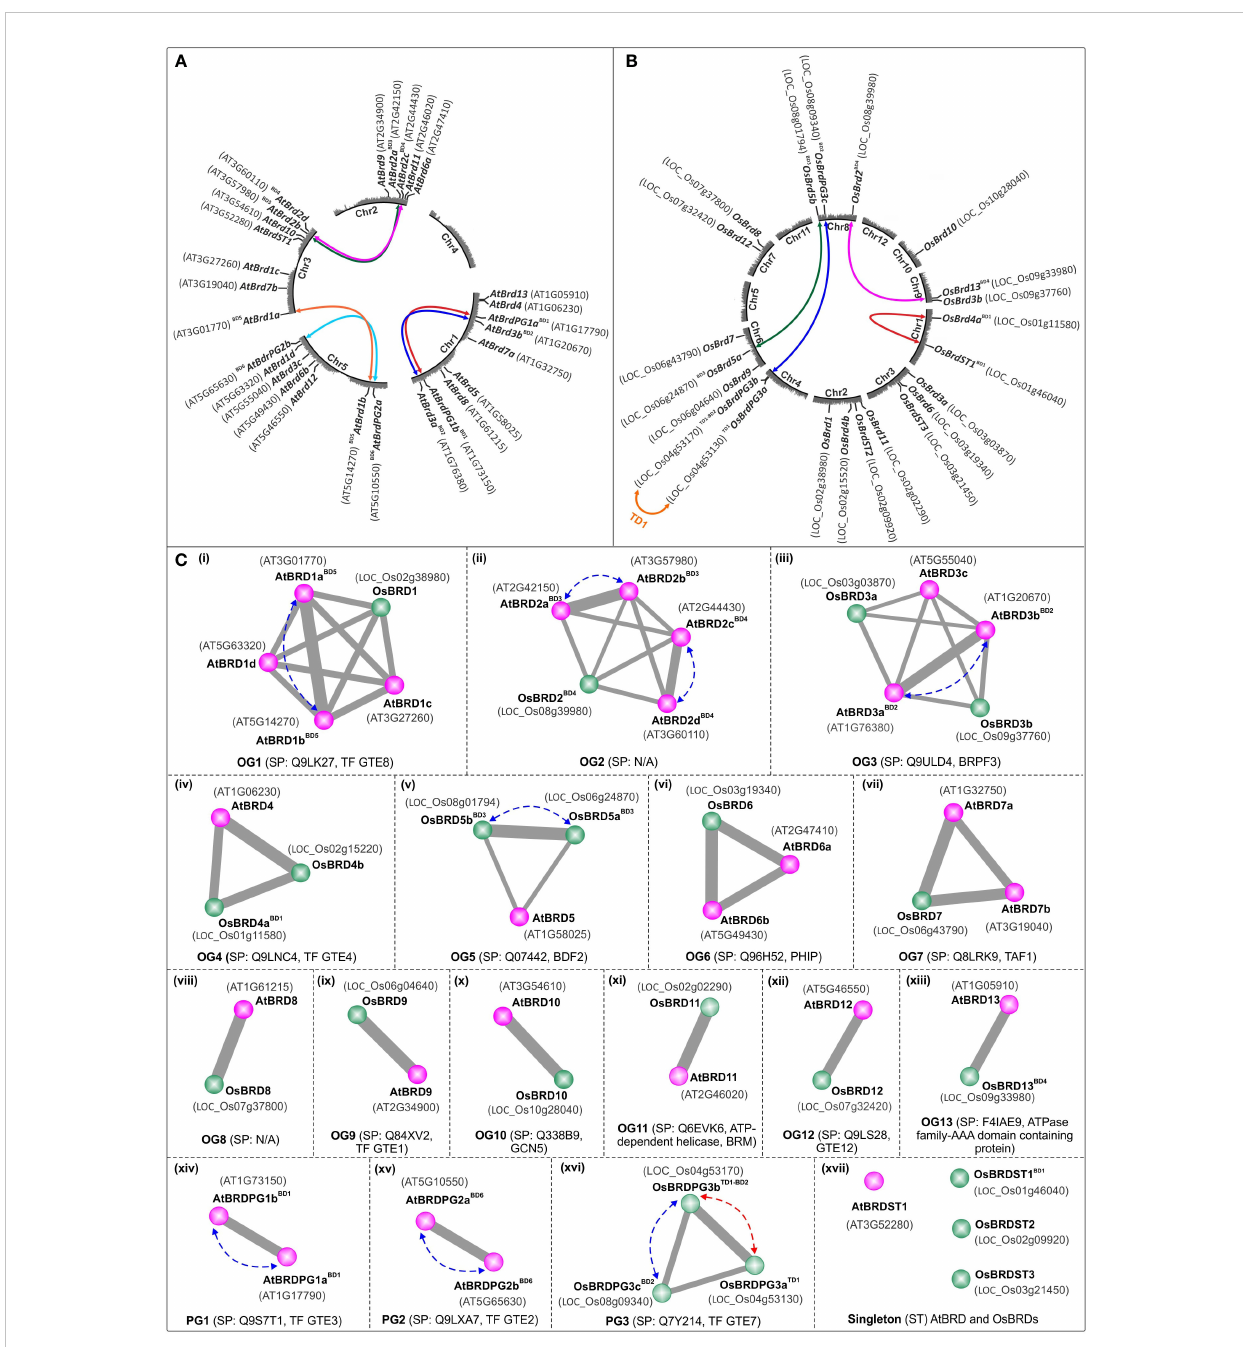
FIGURE 1 Circle-plot representation of chromosomal distribution of Brd -genes in A. thaliana (A) and O. sativa (B) genomes. The gene designations are indicated in bold font, while the locus numbers, as per TAIR (for AtBrds ) and RGAP (for OsBrds ) databases, are given in the parenthesis. Colored connecting lines indicate the tandem/block-duplicated Brd -genes, ‘ Chr1-5 ( A. thaliana )/Chr1-12 ( O. sativa ) ’ indicate chromosome numbers, ‘ BD ’ and ‘ TD ’ indicate block and tandem duplication events. (C) Conserved ortholog groups (OGs), paralog groups (PGs), and singleton BRD-members (STs), in A. thaliana (purple circles) and O. sativa (green circles), as per orthology analysis at Orthovenn2 server (https://orthovenn2.bioinfotoolkits.net/). Blue and red colored dotted lines indicate the block-duplicated (BD, blue line) and tandem-duplicated (TD, red line) Brds, while the functional information (based on SwissProt IDs) is indicated in the parenthesis (N/A indicates ‘ No Hit ’